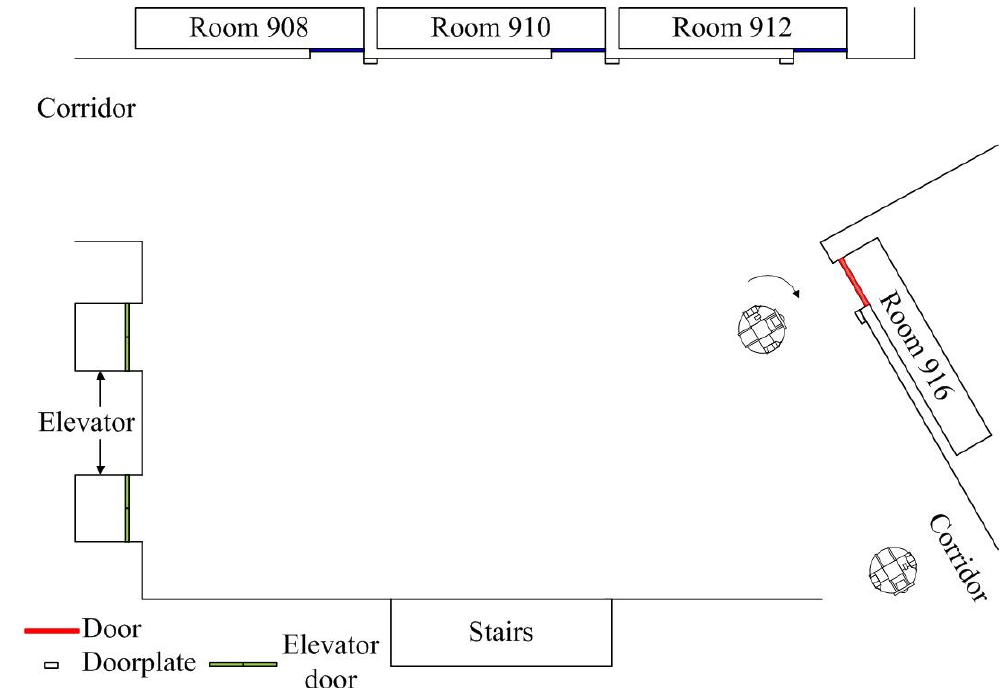
Figure 24. If the verification result is positive, the second robot turns right.